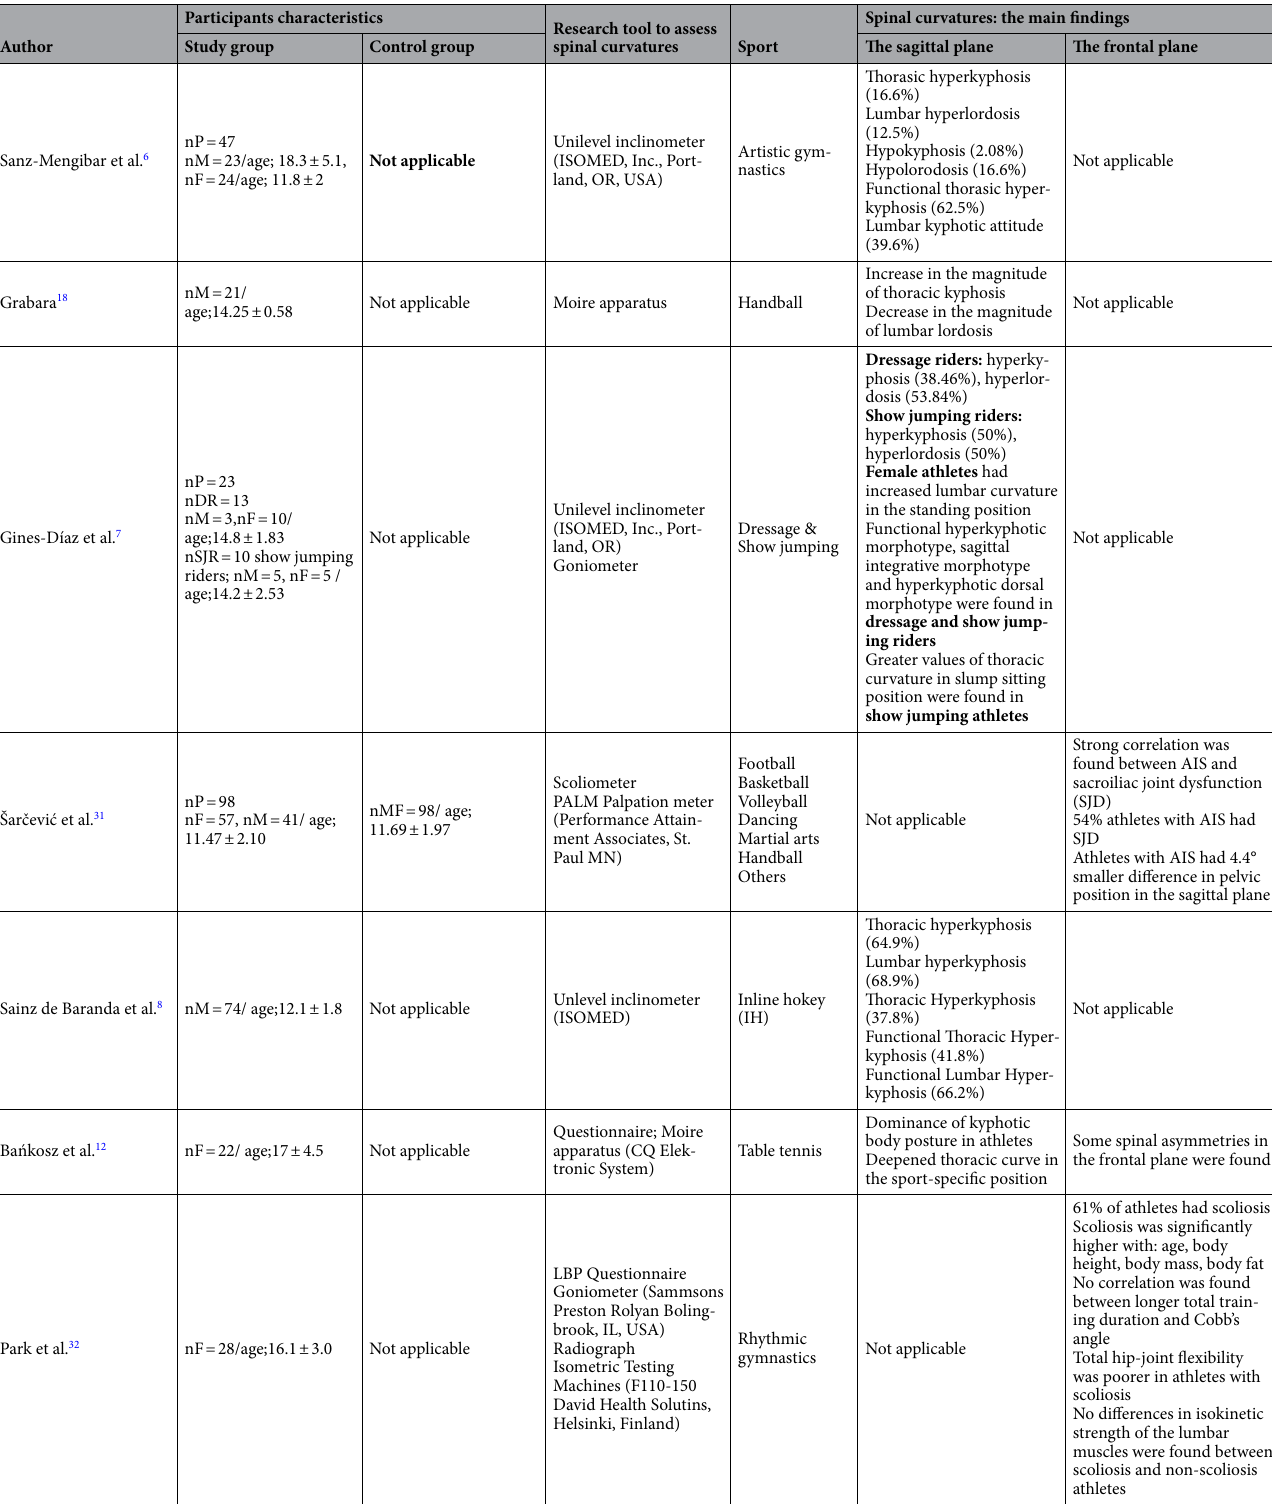
Table 2. The summary of the studies from 2011 to 2021 evaluating the effects of sport-specific training on the magnitude of spinal curvatures and athlete’s body posture (sagittal and frontal planes). nP number